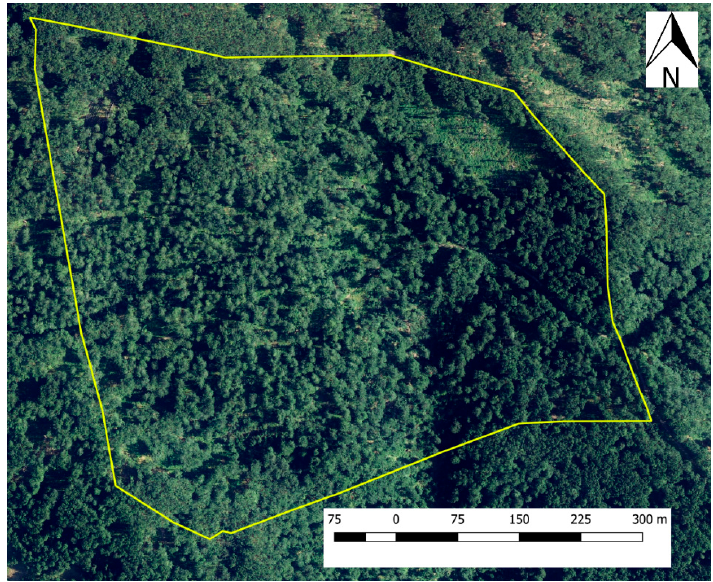
Figure 4. BS with an orthophoto from 2015 with a spatial resolution of 0.2